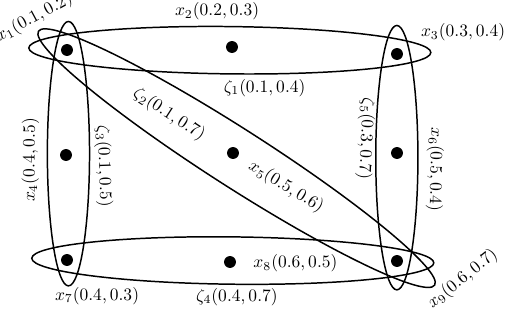
Figure 2. Four-rung orthopair fuzzy hypergraph.